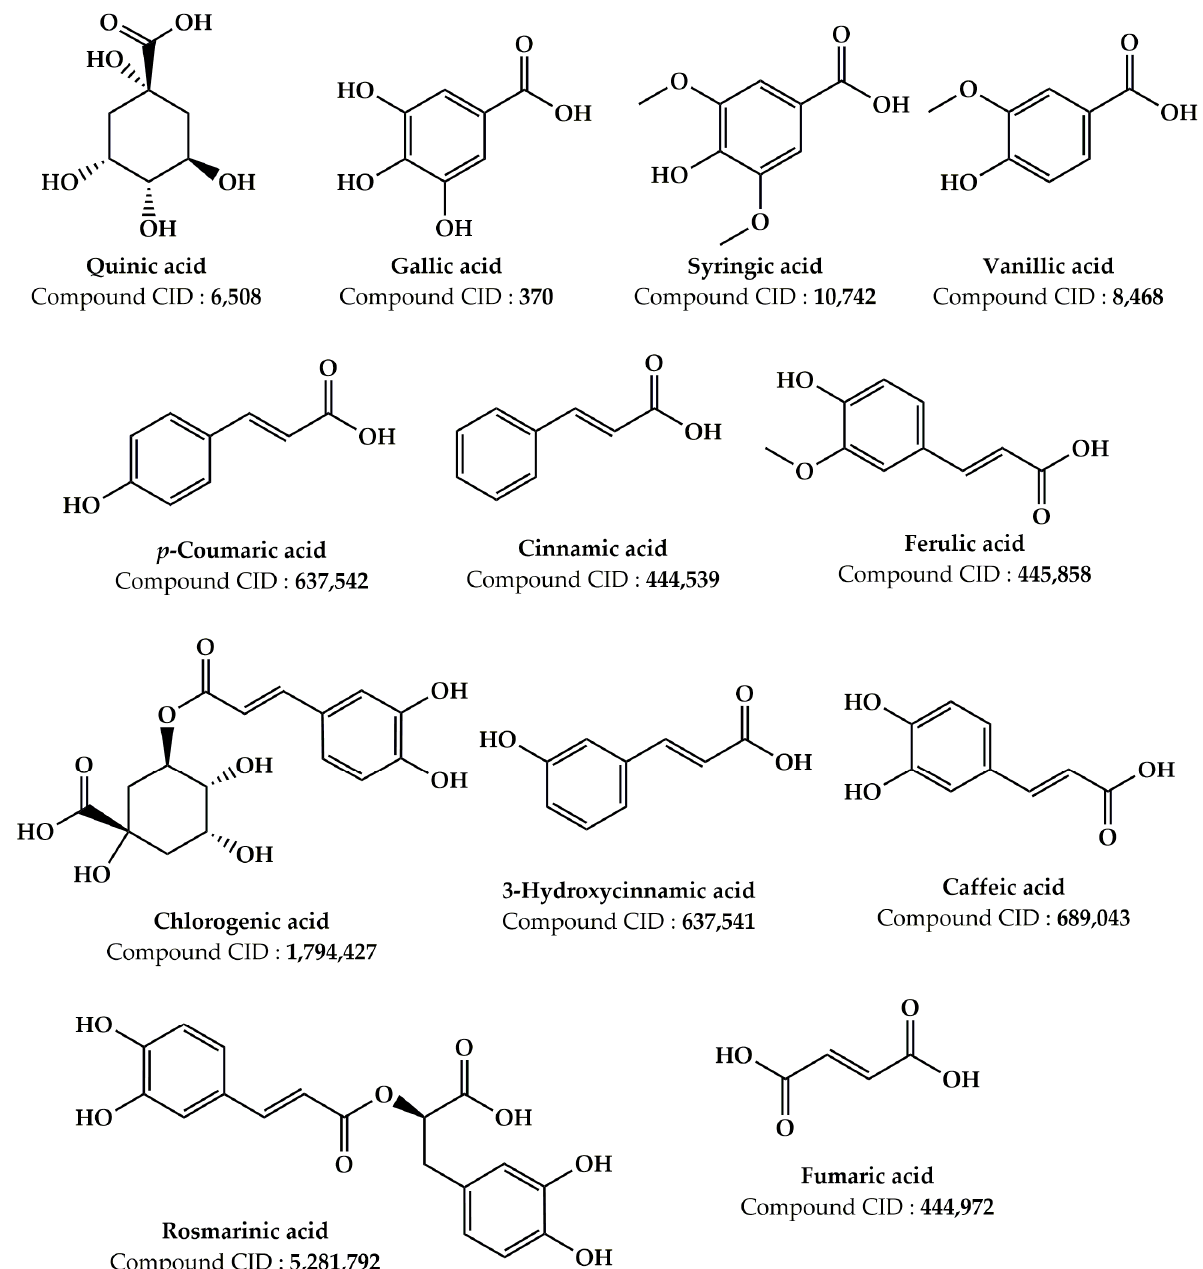
Figure 2. Chemical structures of the main phenolic compounds detected in the Z. lotus extracts.